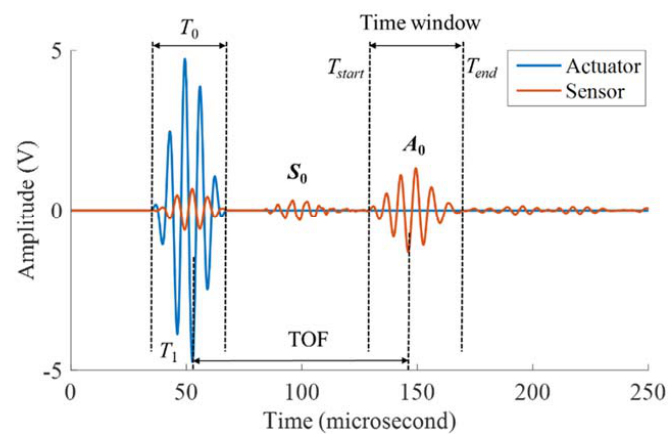
Figure 2. Schematic illustration for the time window calculation.